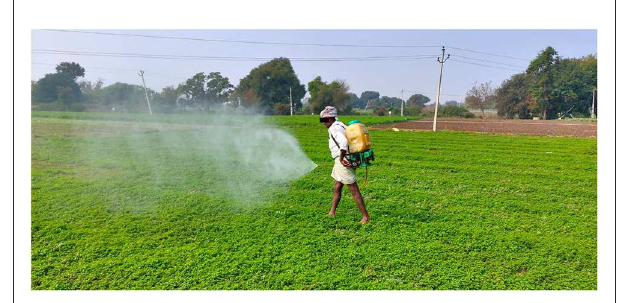
FIGURE2 Farm-worker involved in the spraying of pesticides using backpack pump without following safety protocols.